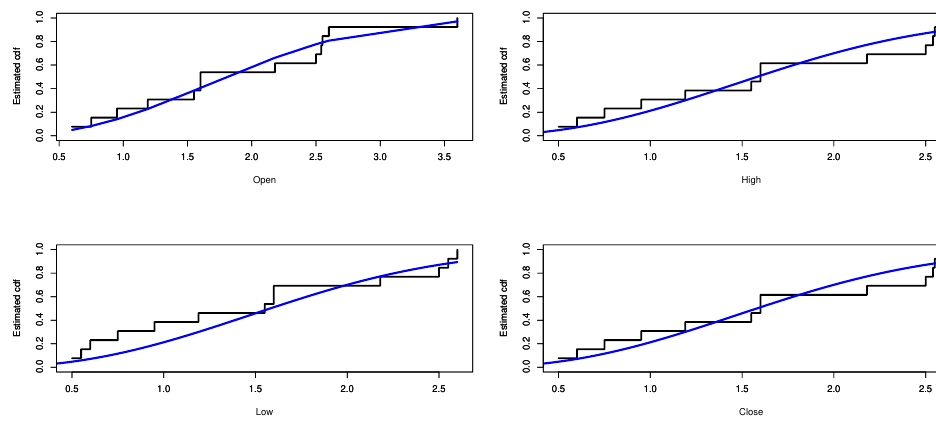
Figure 5. The estimated CDF of E-WD for the stock